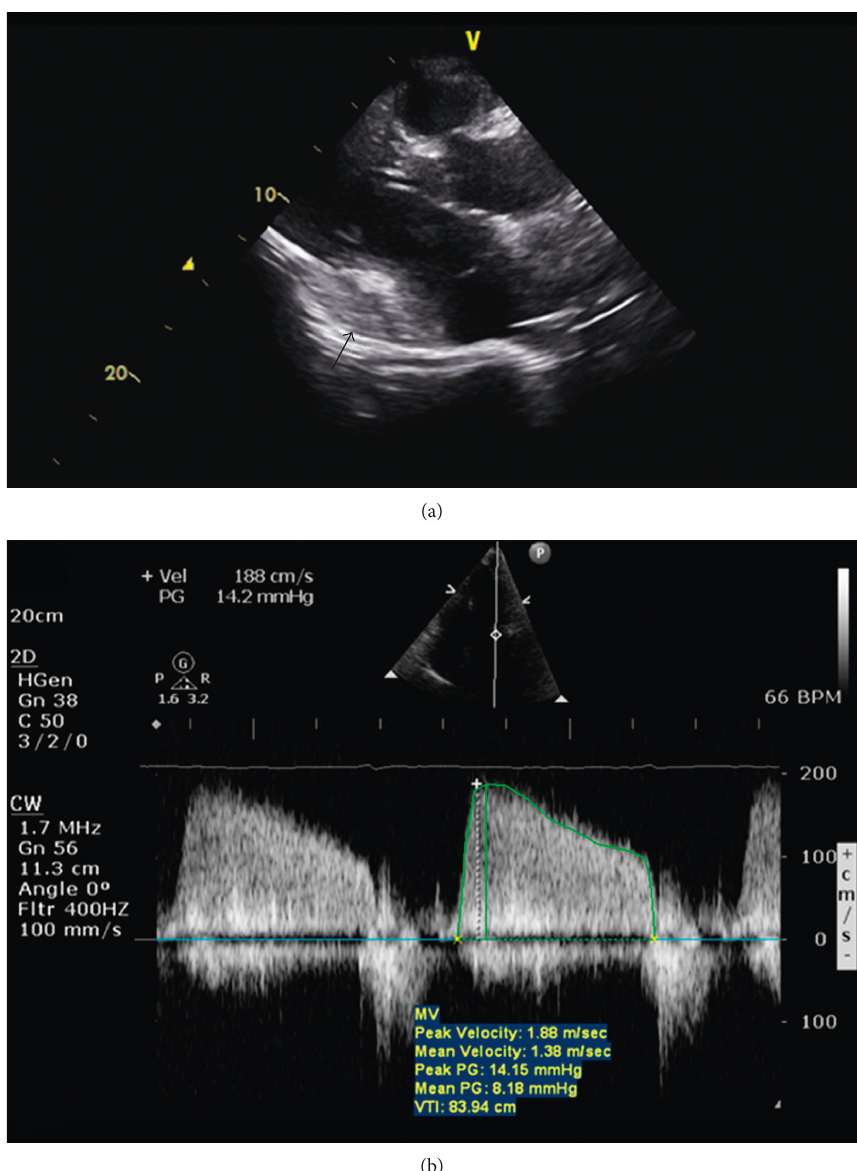
Figure 3: (a) Emergency transthoracic echocardiogram showing accumulation of hematoma around the coronary sinus and atrioventricular groove. (b) Pulse Doppler in the apical 4-chamber view across the mitral valve showing elevated mean pressure gradient of 8mmHg, suggesting functional mitral stenosis secondary to compression of the left atrium and mitral valve